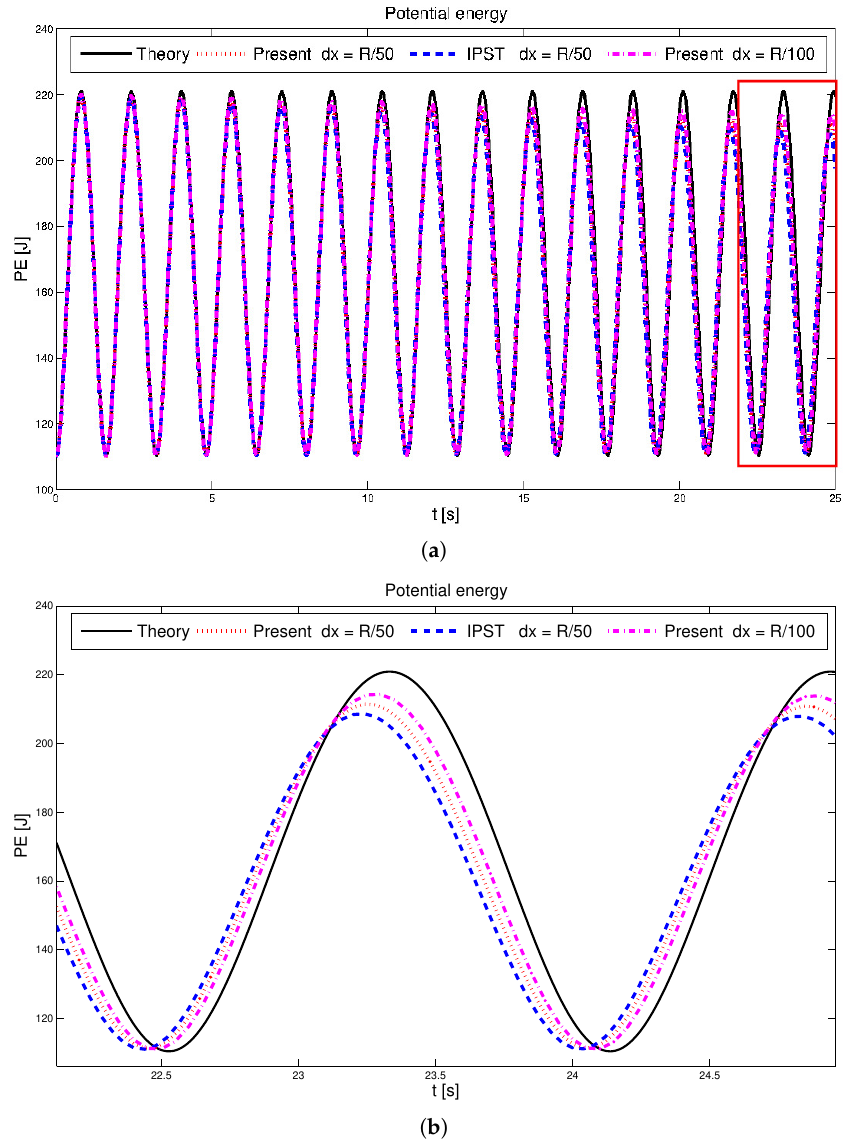
Figure 11. Oscillating droplet under a central conservative force field: Potential Energy evolution in time E p ( t ) . The black solid line presents the theoretical results obtained by solving the system (18) [60]. The red dotted line represents the results obtained by the present particle shifting formulation for the fluid droplet of resolution dx = R , whereas for the magenta dash-dot line is for dx = R . The blue 50 100 dashed line represents the results obtained by the particle shifting technology (IPST) proposed by Wang et al. [37]. The bottom part ( b ) of the figure represents the zoom of selected red rectangle in ( a